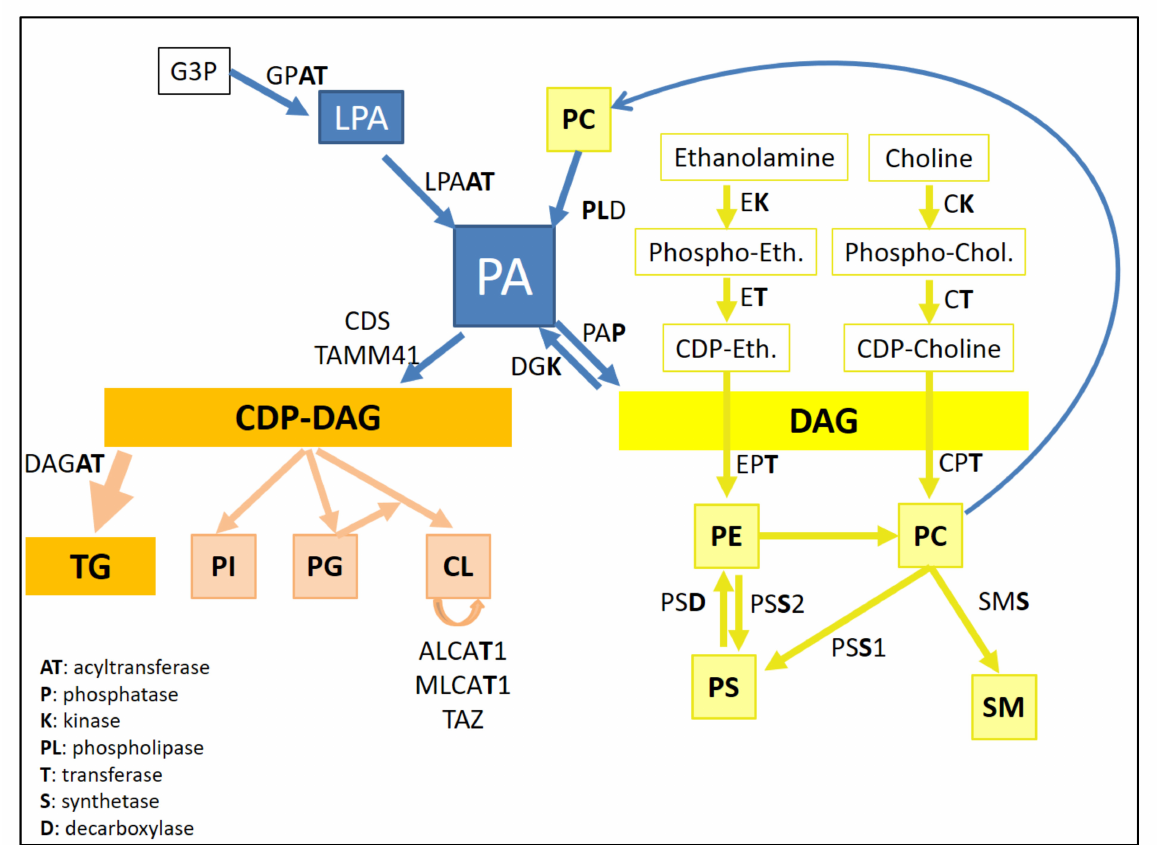
Figure 4. Diacylglycerol (DAG) and CDP-DAG are two key elements in PL biosynthesis. GPAT: glycerol-3-phosphate acyltransferase, LPAAT: lysophosphatidic acid acyltransferases, PAP: phosphatidic acid phosphatases, DGK: diacylglycerol kinase, CDS: CDP-DAG synthetase, DAGAT: diacylglycerol acyl transferase, ALCAT1: AcylCoA:lysoCL acyltransferase 1, MLCAT1: monolysoCL acyltransferase 1, TAZ: tafazzin, EK: ethanolamine kinase, ET: CTP:phosphoethanolamine PE cytidy- lyltransferase, EPT: ethanolaminephosphotransferase, PSD: phosphatidylserine decarboxylase, PSS2: phosphatidylserine synthase 2, CK: choline kinase, CT: CTP: phosphocholine cytidylyltransferase, CPT: cholinephosphotransferase, PSS1: phosphatidylserine synthase 1, SMS: sphingomyelin